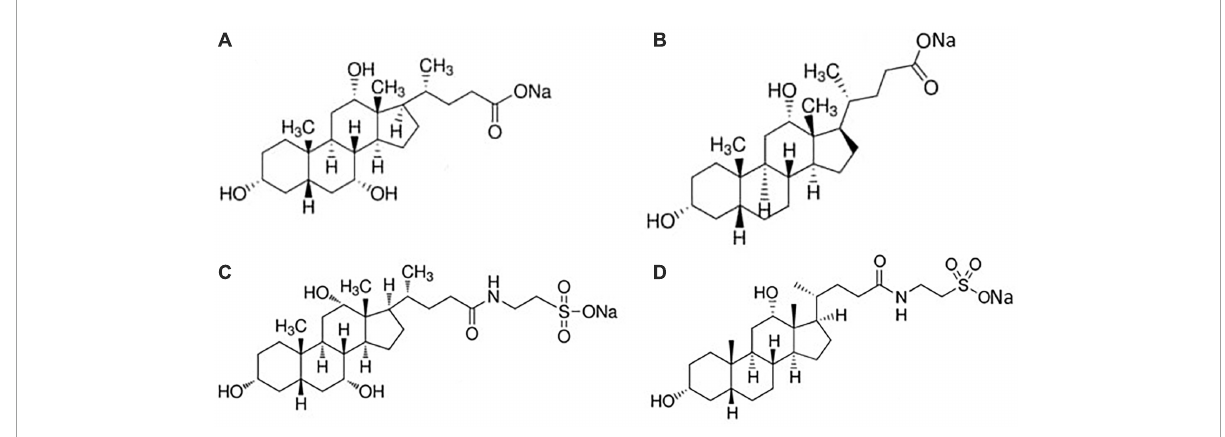
FIGURE3 Structures of (A) sodium cholate; (B) sodium deoxycholate; (C) sodium taurocholate; (D) sodium